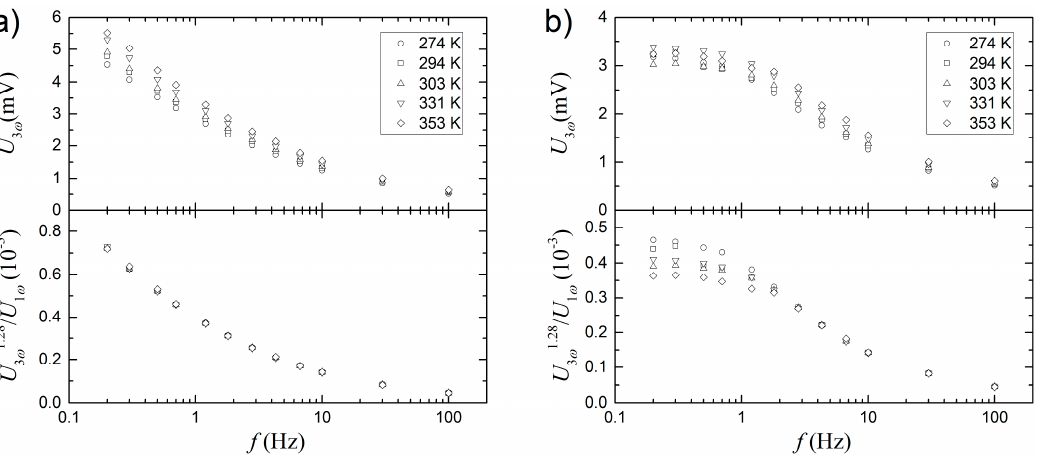
Figure 7 . Frequency dependence of (cid:1847) (cid:2869)(cid:3104) and (cid:1847) (cid:2871)(cid:3104) at different temperatures. The top panels show the Figure 7. Frequency dependence of U 1 ω and U 3 ω at different temperatures. The top panels show the raw measurements of (cid:1847) (cid:2871)(cid:3104) and the bottom panels show ((cid:1847) (cid:2871)(cid:3104) ) (cid:2869).(cid:2870)(cid:2876) /(cid:1847) (cid:2869)(cid:3104) . ( a ) Stirring is off; ( b ) Stirring raw measurements of U 3 ω and the bottom panels show ( U 3 ω ) 1.28 / U 1 ω . ( a ) Stirring is off; ( b ) Stirring is on. is